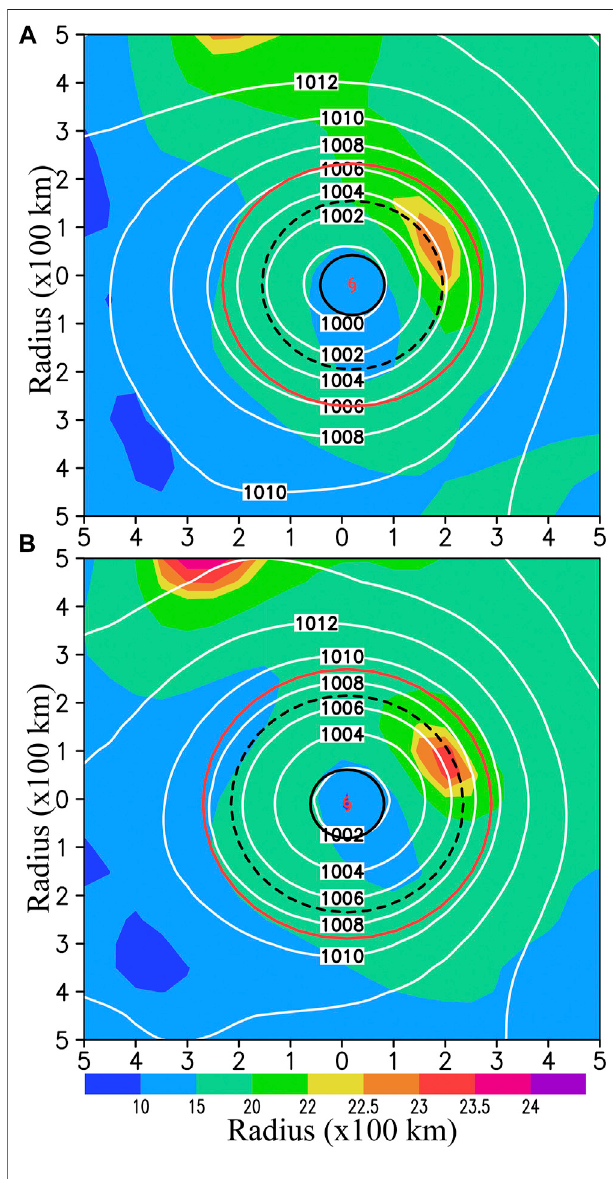
height, m s − 1 ) and the sea level pressure (white contours, hPa) obtained from CFSR at (A) 1800 UTC Sep 17, 2006 and (B) 0000 UTC Sep 18, 2006. The black and red circles indicate the RMW and the radius of the 34-kt wind (R17) in the best track data, while the black dashed circle is the azimuthal- mean RMW in the CFSR data.